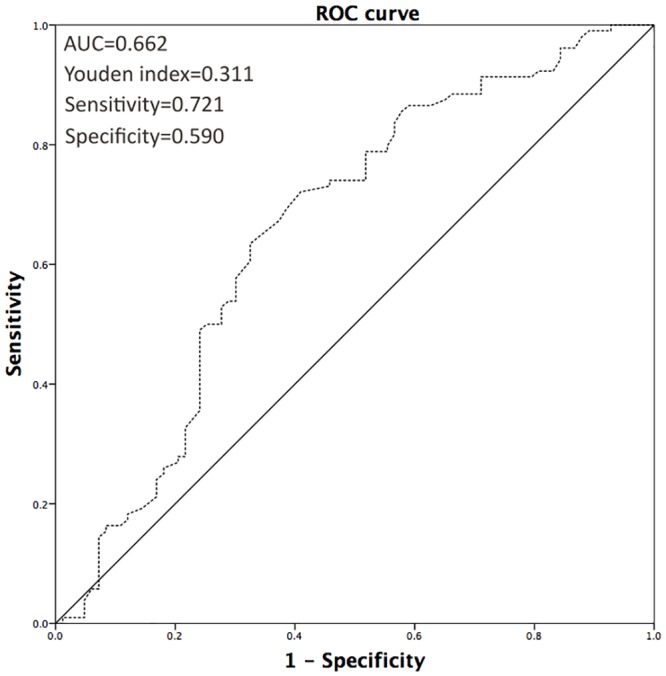
ROC analysis of optimal AGR cutoff.